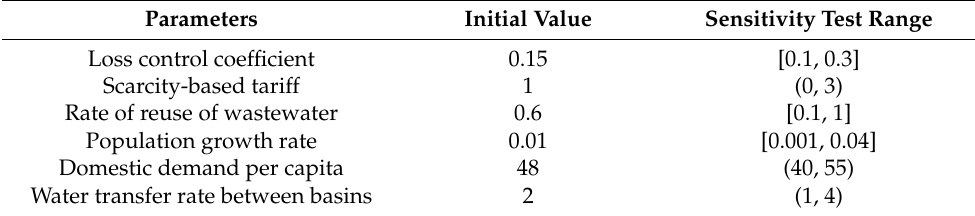
Table 3. Parameters used in the sensitivity analysis.